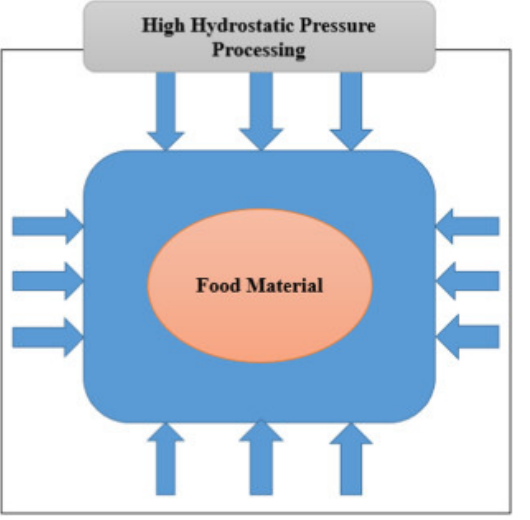
Figure 3. The food system under high hydrostatic pressure showing how the latter gets applied from all sides to the food material (Source: Khan et al. [36]; permission to use given by Elsevier